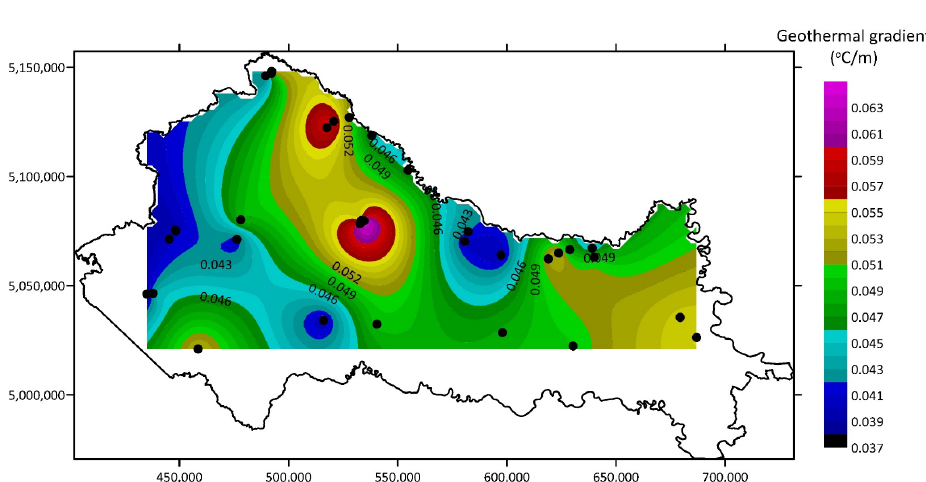
Figure 15. Geothermal gradient map for pre-rift phase. The spatial distribution of the mean values of the probability distribution of heat in place in the affected doublet area is shown in Figure 16 for the post-rift phase, Figure 17 for the syn-rift phase, and Figure 18 for post-rift phase.